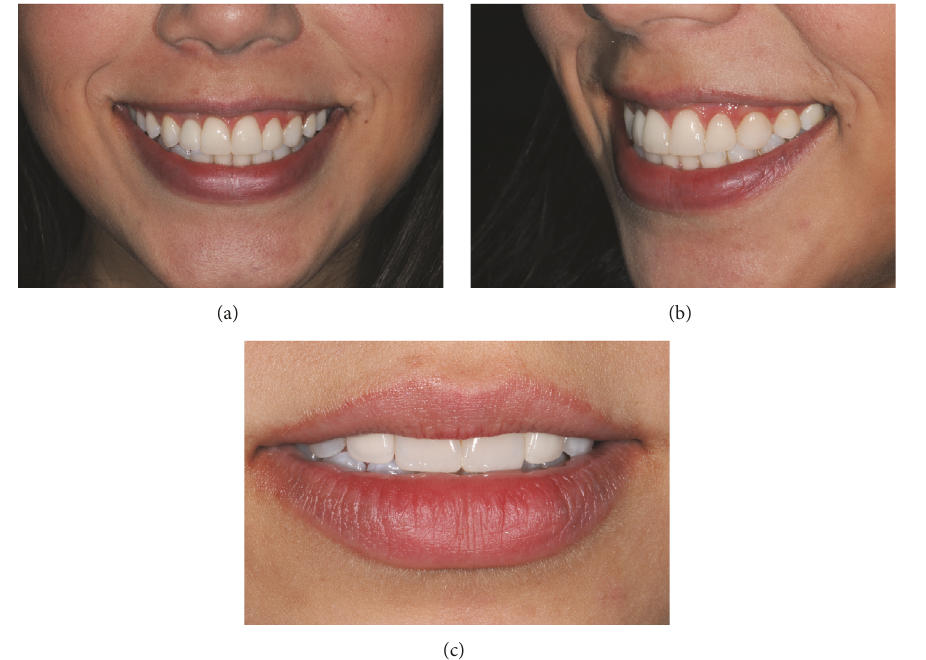
Figure 10: Frontal and lateral views of the patient’s final smile. Final view of the teeth with resting lip, demonstrating improved translucency of the prosthesis over the